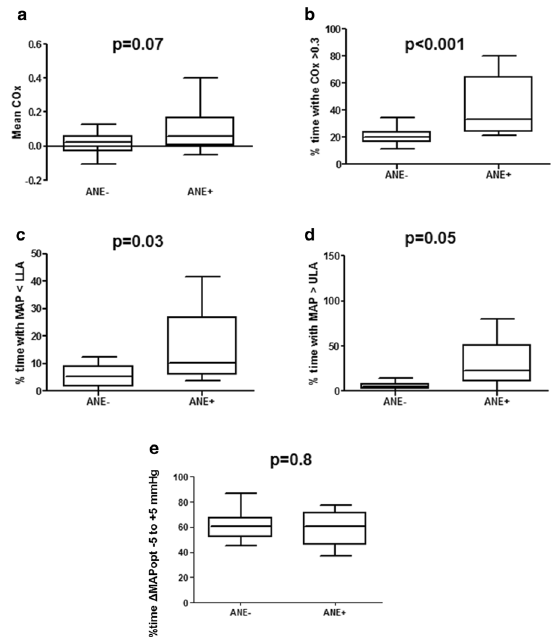
Fig. 3 Autoregulation parameters according to neurological outcome. A. Mean COx. B. Percentage of time with COx > 0.3. C. Percentage of time with MAP < LLA. D. Percentage of time with MAP > ULA. E. Per- centage of time with MAP—MAPopt between Area Under; MAP, Mean Arterial Pressure; LLA, Lower Limit of